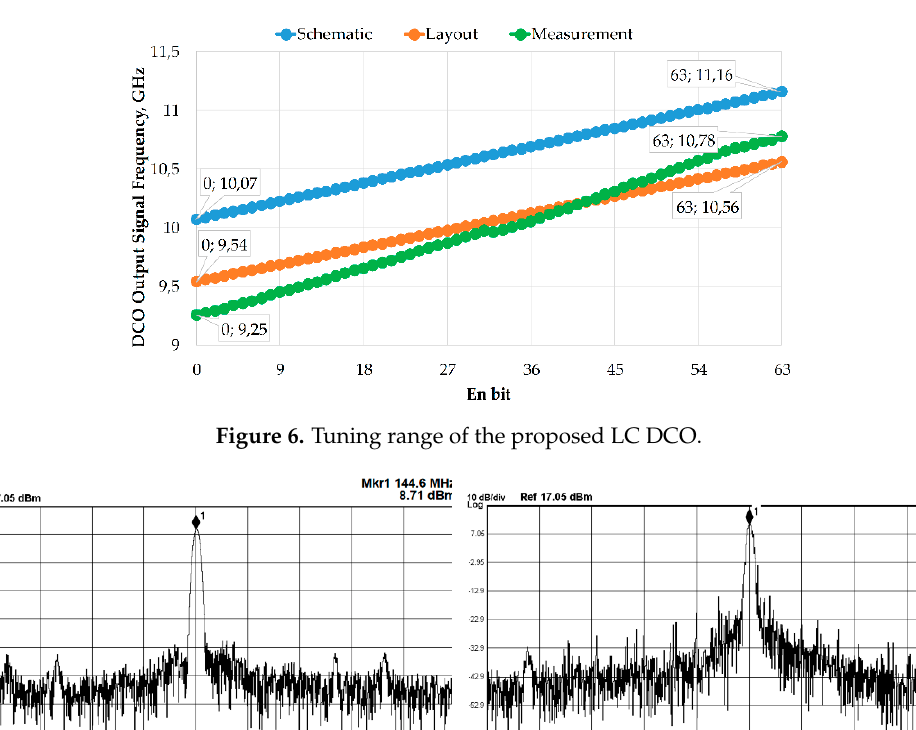
Figure 6. Tuning range of the proposed LC DCO.